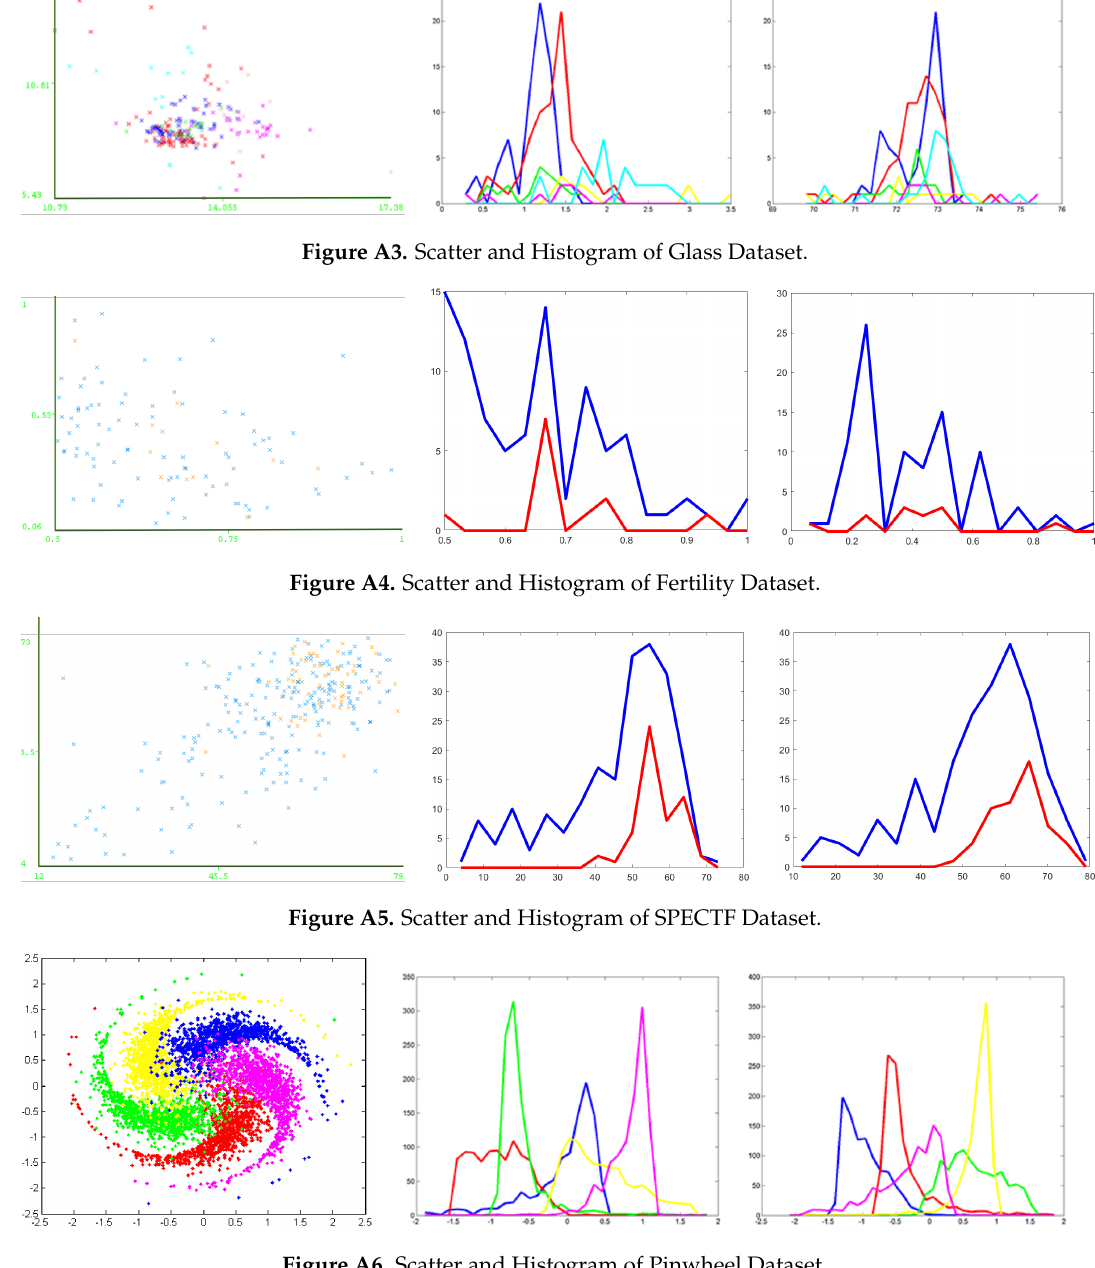
Figure A6. Scatter and Histogram of Pinwheel Dataset.